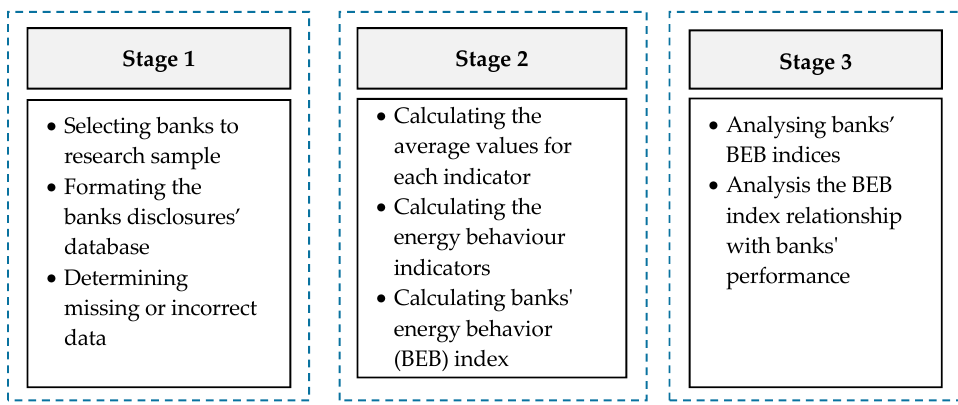
Table 1. The BEB index indicators.